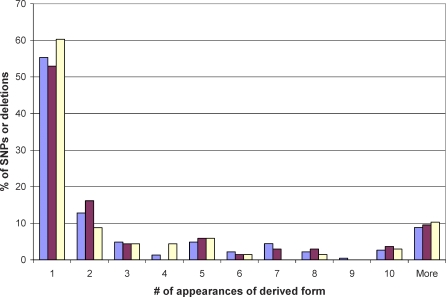
Frequency Distribution of Nonsynonymous Mutations, Synonymous Mutations, and Genomic Deletions in MTBC StrainsFor each site that underwent a mutation within MTBC we observed two states: the derived (or mutated) state, and the ancestral state. For synonymous and nonsynonymous mutations we deduced the ancestral state based on the sequence of the outgroup strain M. canettii. For the genomic deletions (originally described in [44]), the ancestral state is the non-deleted state and the deleted state is derived. The frequencies depicted here are those of the mutated states. All three types of mutations show similar frequency distributions, which suggests that most nonsynonymous mutations and deletions are not slightly deleterious but rather selectively neutral within MTBC. Blue, nonsynonymous mutations; red, synonymous mutations; yellow, genomic deletions.